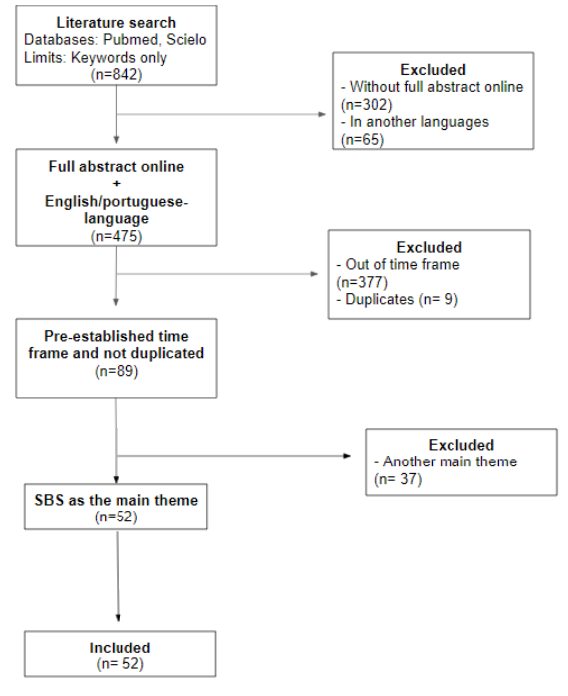
Figure 1: Flow diagram of search strategy and study selection veins, amongst them the main ones, called bridge- veins. This rupture cause extra-axial hemorrhage, mainly subdural and subarachnoid